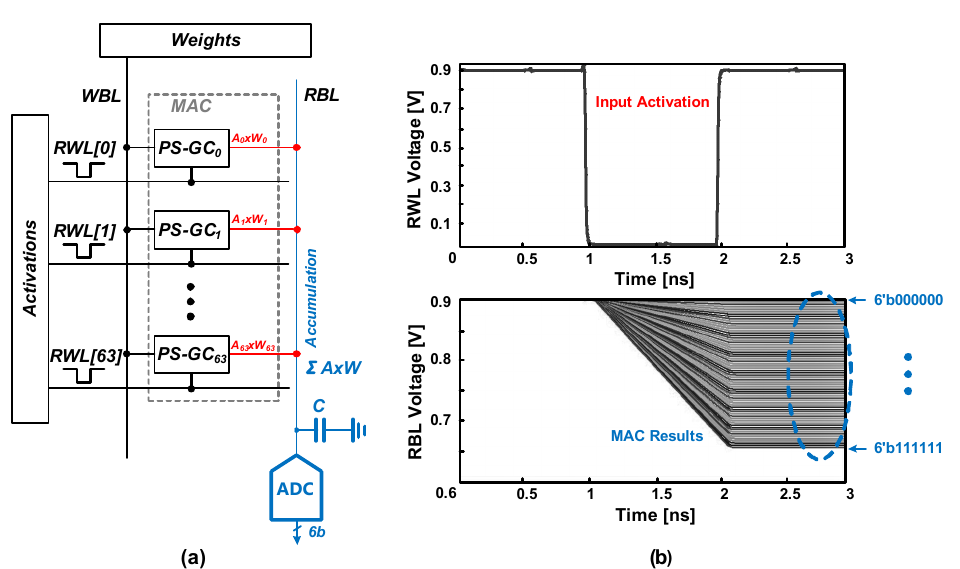
Figure 10. ( a ) PIM configuration example of PS-GC eDRAM. ( b ) RBL discharge plot of all accumu- lation results.